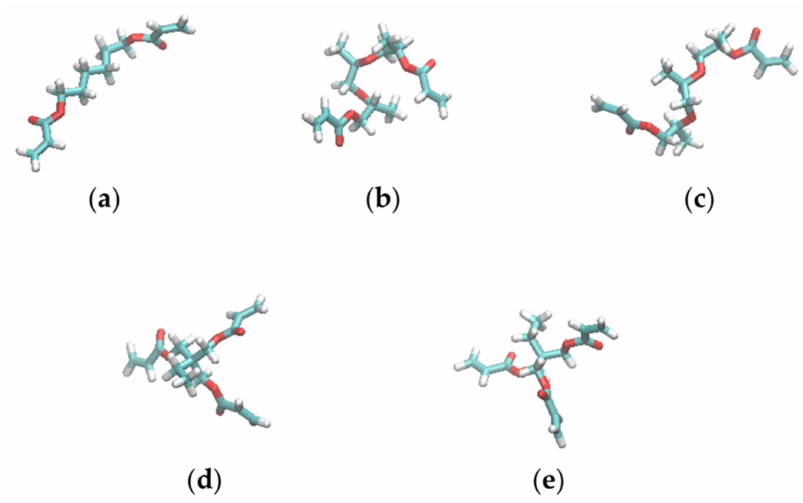
Figure 5. Representative structures of the multi-functional resist molecules in MD simulations. ( a ) HDDA with κ 2 = 0.8, ( b ) TPGDA with κ 2 = 0.2, ( c ) TPGDA with κ 2 = 0.6, ( d ) TMPTA with κ 2 = 0.15, and ( e ) TMPTA with κ 2 = 0.25. The figures were generated by VMD [19].